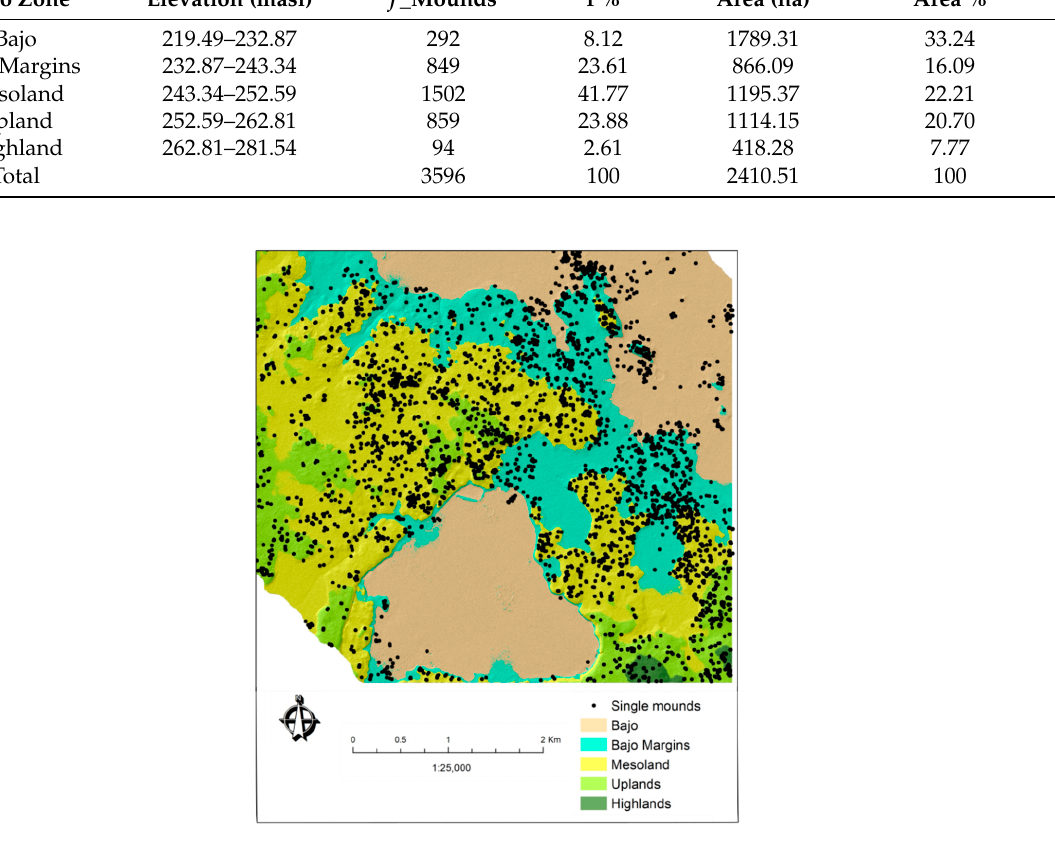
Figure 7. Percentage of archaeological settlements located in each type of contemporary forest. Table 3. Topographic zone mound density.